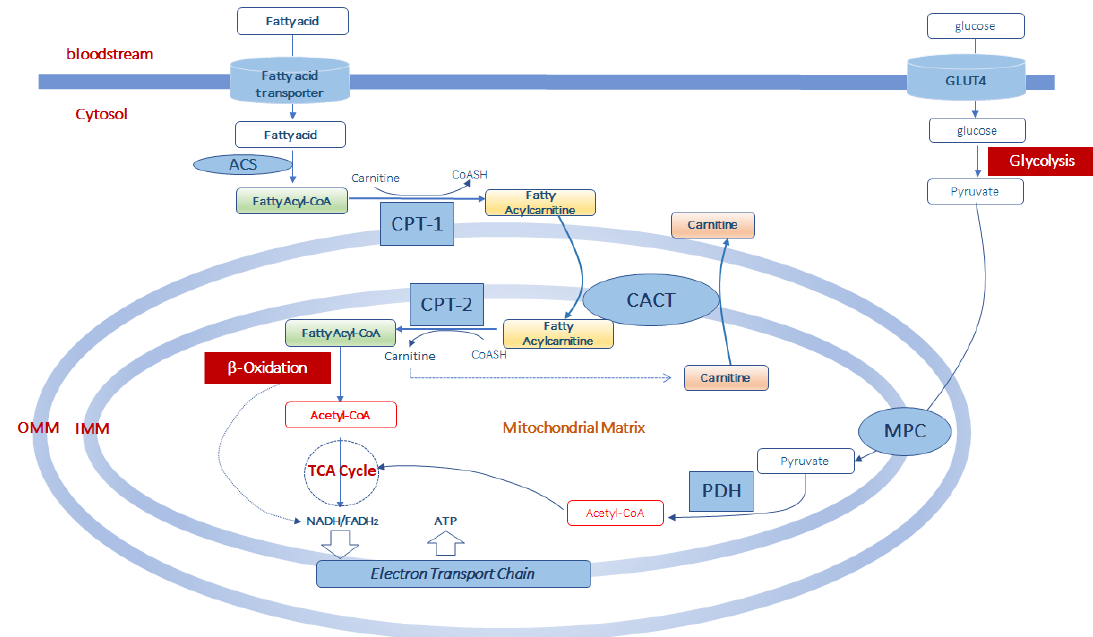
Figure 1. Acetyl-CoA production from fatty acid and glucose metabolism in muscle mitochondria. Fatty acids enter the cells by fatty acid transporters. Once in the cell they are activated to fatty acyl-CoA by acyl-CoA synthetase (ACS) before entering the mitochondria. At the level of the outer part of the outer mitochondrial membrane (OMM), fatty acyl-CoAs are bind to carnitine, by carnitine palmitoyltransferase-1 (CPT-1) activity, to form fatty acylcarnitine derivatives which diffuse through the outer mitochondrial membrane. Thus, the formed fatty acylcarnitines are transported across the inner mitochondrial membrane (IMM) via carnitine-acylcarnitine translocase (CACT). In the mitochondrial matrix, CPT-2 converts fatty acylcarnitines back to fatty acyl-CoAs, which enters the β -oxidation pathway, and to free carnitine which can exit from the mitochondria in exchange with other acylcarnitines through CACT. Mitochondrial acetyl-CoA is generated from both β -oxidation of fatty acids and from pyruvate. Pyruvate is formed in the glycolytic pathway form glucose which enters the muscle cell via the glucose transporter type 4 (GLUT4). Pyruvate is transported in the mitochondrial matrix by the pyruvate carrier (MPC) of the inner mitochondrial membrane. Once in the mitochondria, pyruvate is converted into acetyl-CoA throughout the complex of the pyruvate dehydrogenase (PDH). This acetyl-CoA, together with that formed in the β -oxidation pathway can enter the tricarboxylic acid cycle (TCA cycle) to produce equivalent donors in the form of NADH (H + ) and FADH 2 which are oxidized in the mitochondrial electron transport chain to produce ATP.